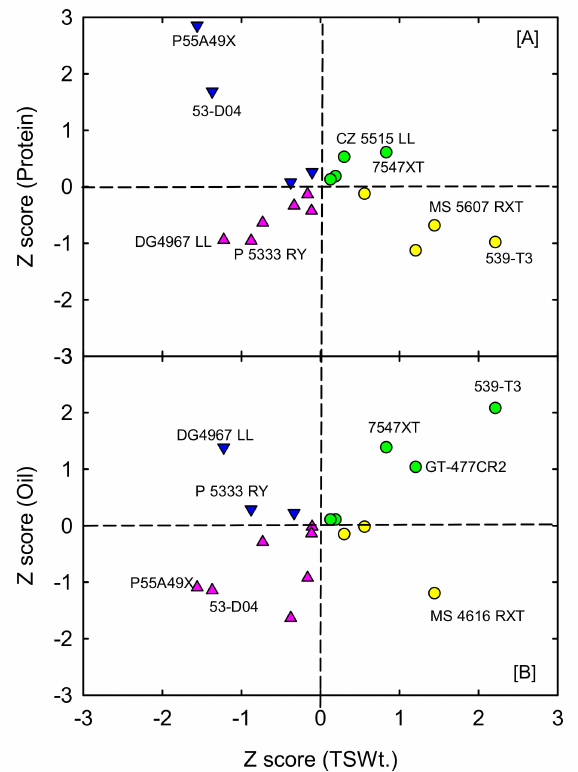
Figure 6. Selection of high-yielding and high-quality soybean cultivars based on seed weight (TSWt.) and protein ( A ) or oil ( B ). Normalized Z scores were estimated for seed weight, protein, and oil for each cultivar, and the computed scores were used to select soybean cultivars with a combination of desirable traits. The figure also shows the selected set of contrasting cultivars for total seed weight and protein ( A ) or oil ( B